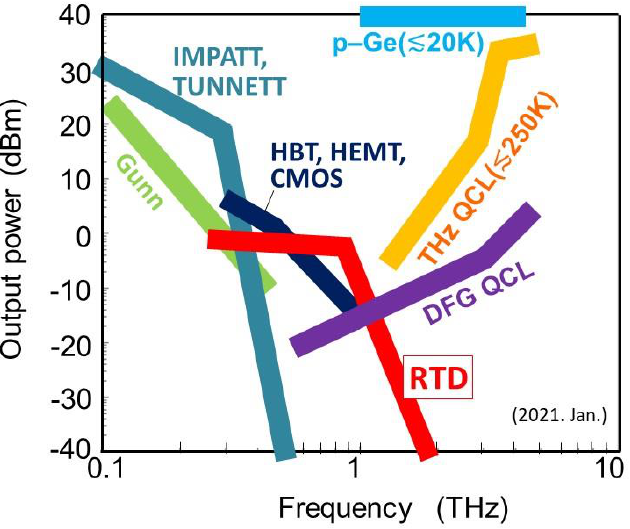
Figure 1. Current status of semiconductor on-chip terahertz (THz) sources. Output power as a function of generated frequency. Devices without temperature indication operate at room temper- ature.